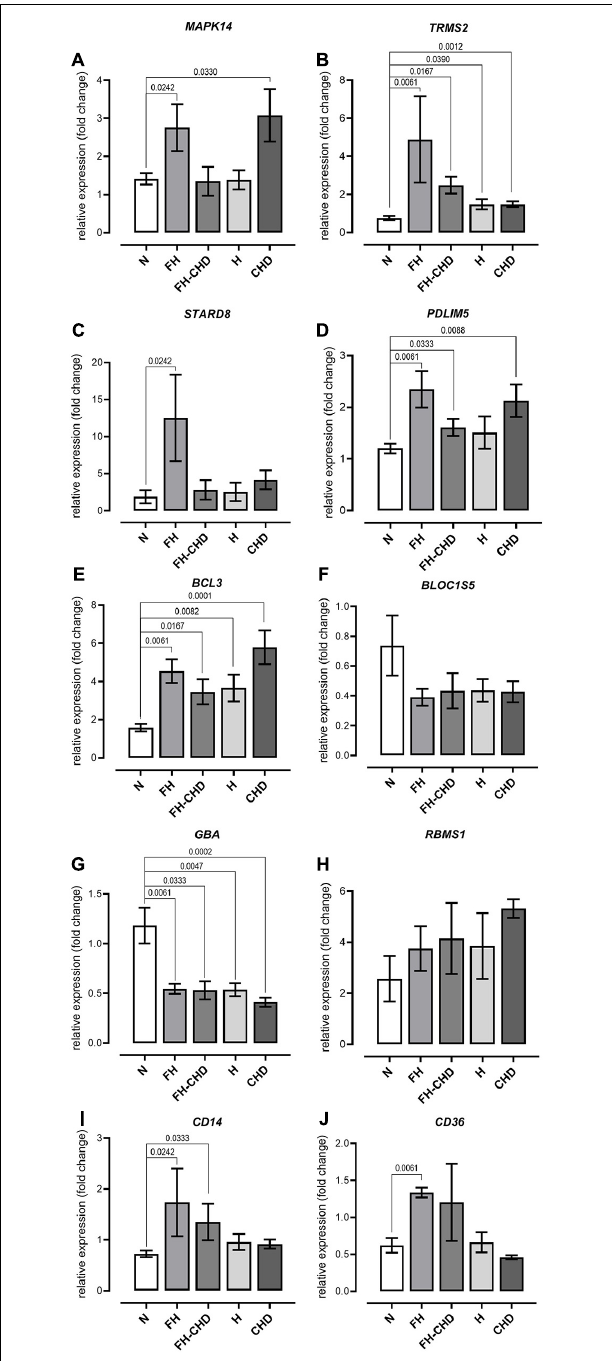
FIGURE 7 | Quantitative reverse transcription PCR analysis of mRNA expression of (A) MAPK14 , (B) TRPM2 , (C) STARD8 , (D) PDLIM5 , (E) BCL3 , (F) BLOC1S5 , (G) GBA , (H) RBMS1 , (I) CD14 , and (J) CD36 genes, showing altered expression in patient groups vs. controls. mRNA expression (2.0-fold change) relative to ACTB mRNA in RNA samples obtained from the patient groups; familial hyperlipidemia (FH; n = 4), familial coronary heart disease (FH-CHD; n = 3), hyperlipidemia (H; n = 6), and coronary heart disease (CHD; n = 10) compared with the healthy (N) group ( n = 7). Bracketed p -values indicate significant differences between